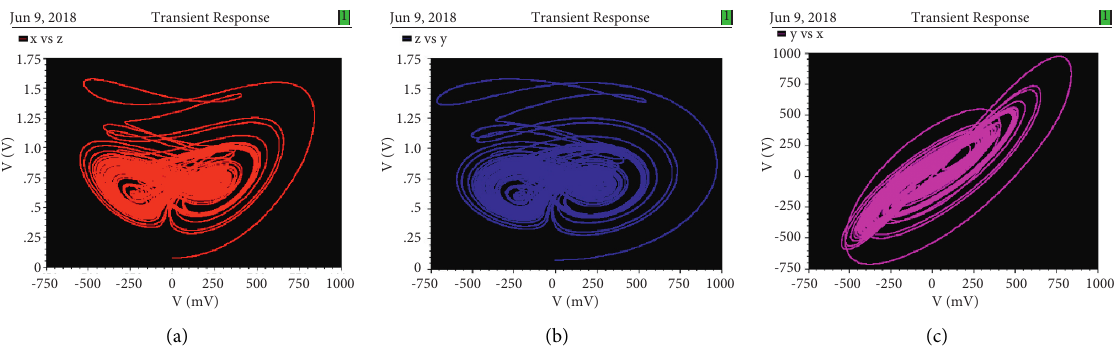
Figure 9: Phase portraits of the Chen’s attractor in (a) x-z plane, (b) z-y plane, and (c) y-x